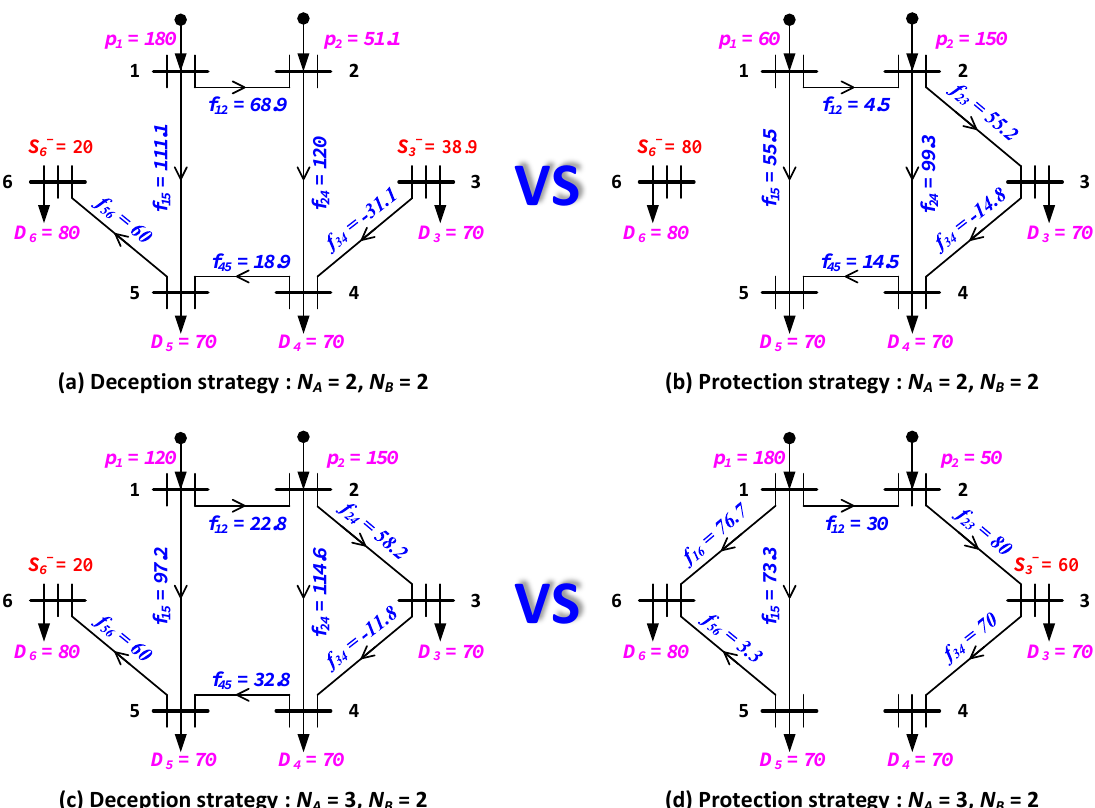
Figure 4. Performance of the optimal deception and protection strategies on the 6-bus system under different defense and attack